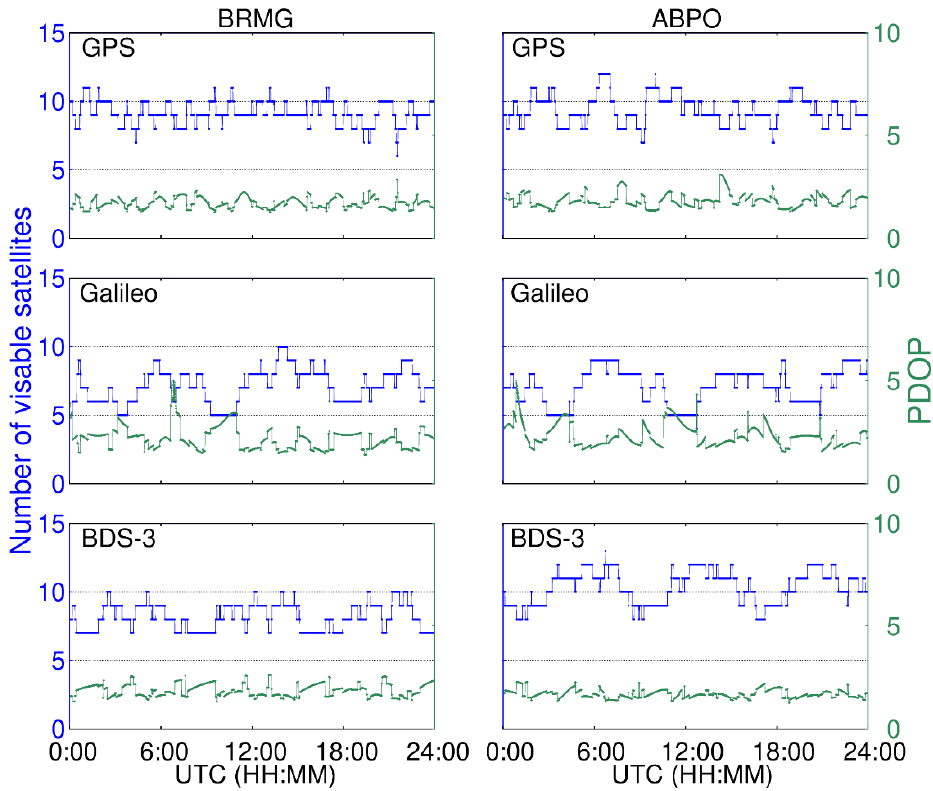
Figure 6. Number of visible satellites and PDOP values for the two tracking stations, BRMG and